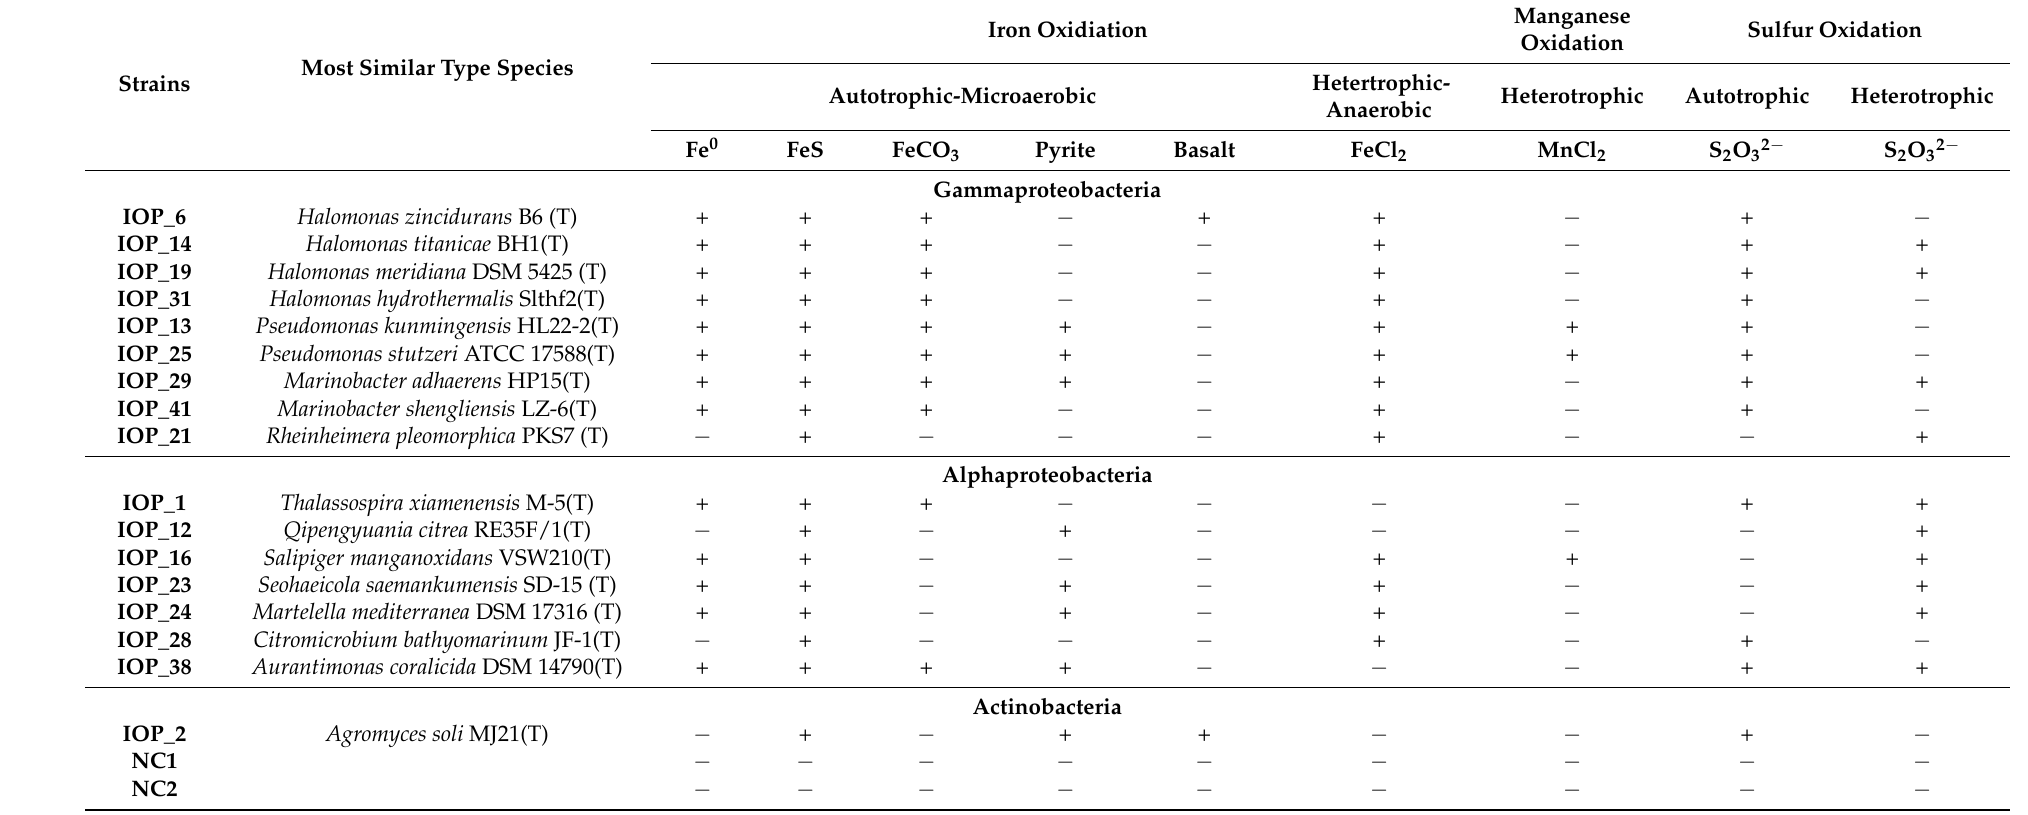
Table 2. Growth substrate tests of isolates in this